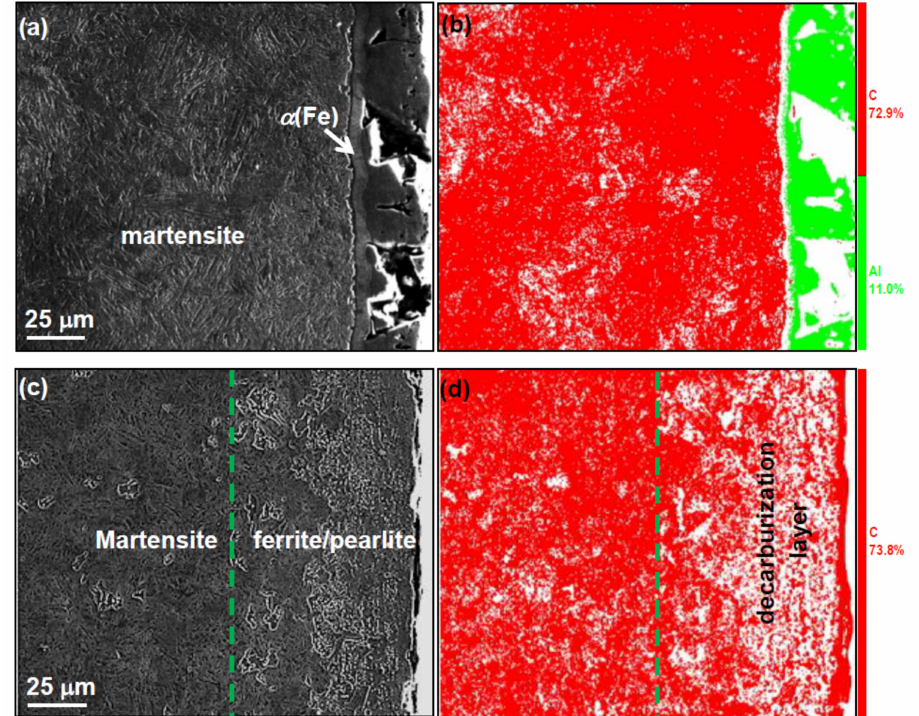
Figure 5. Cross-sectional SEM images and the corresponding C and Al elemental distributions after hot stamping at 1193 K for the coated ( a , b ) and uncoated ( c , d ) specimens.